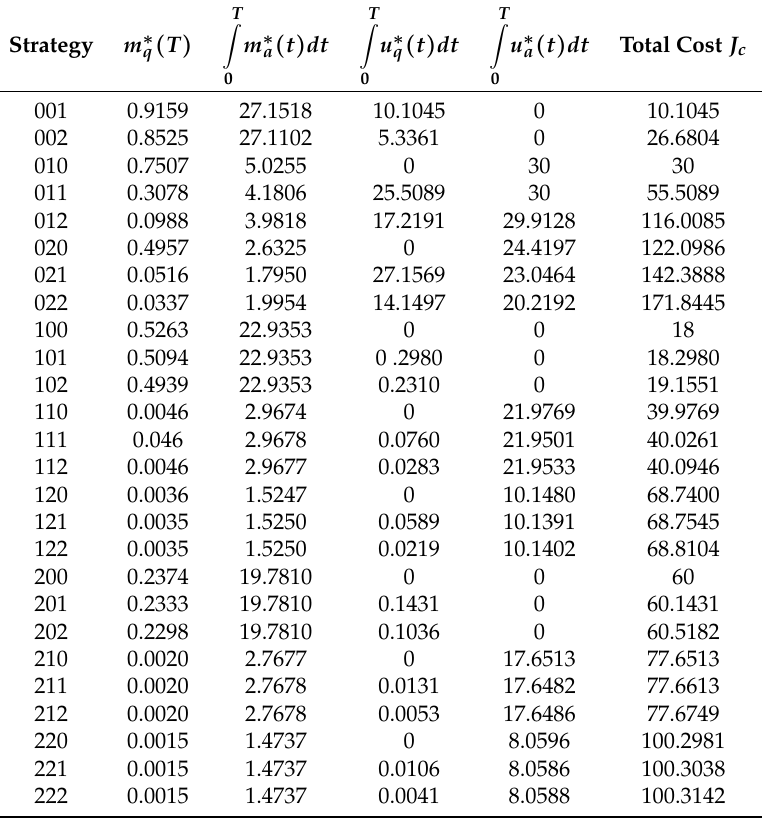
Table 3. Outcomes of numerical solutions of the optimal control problem for each